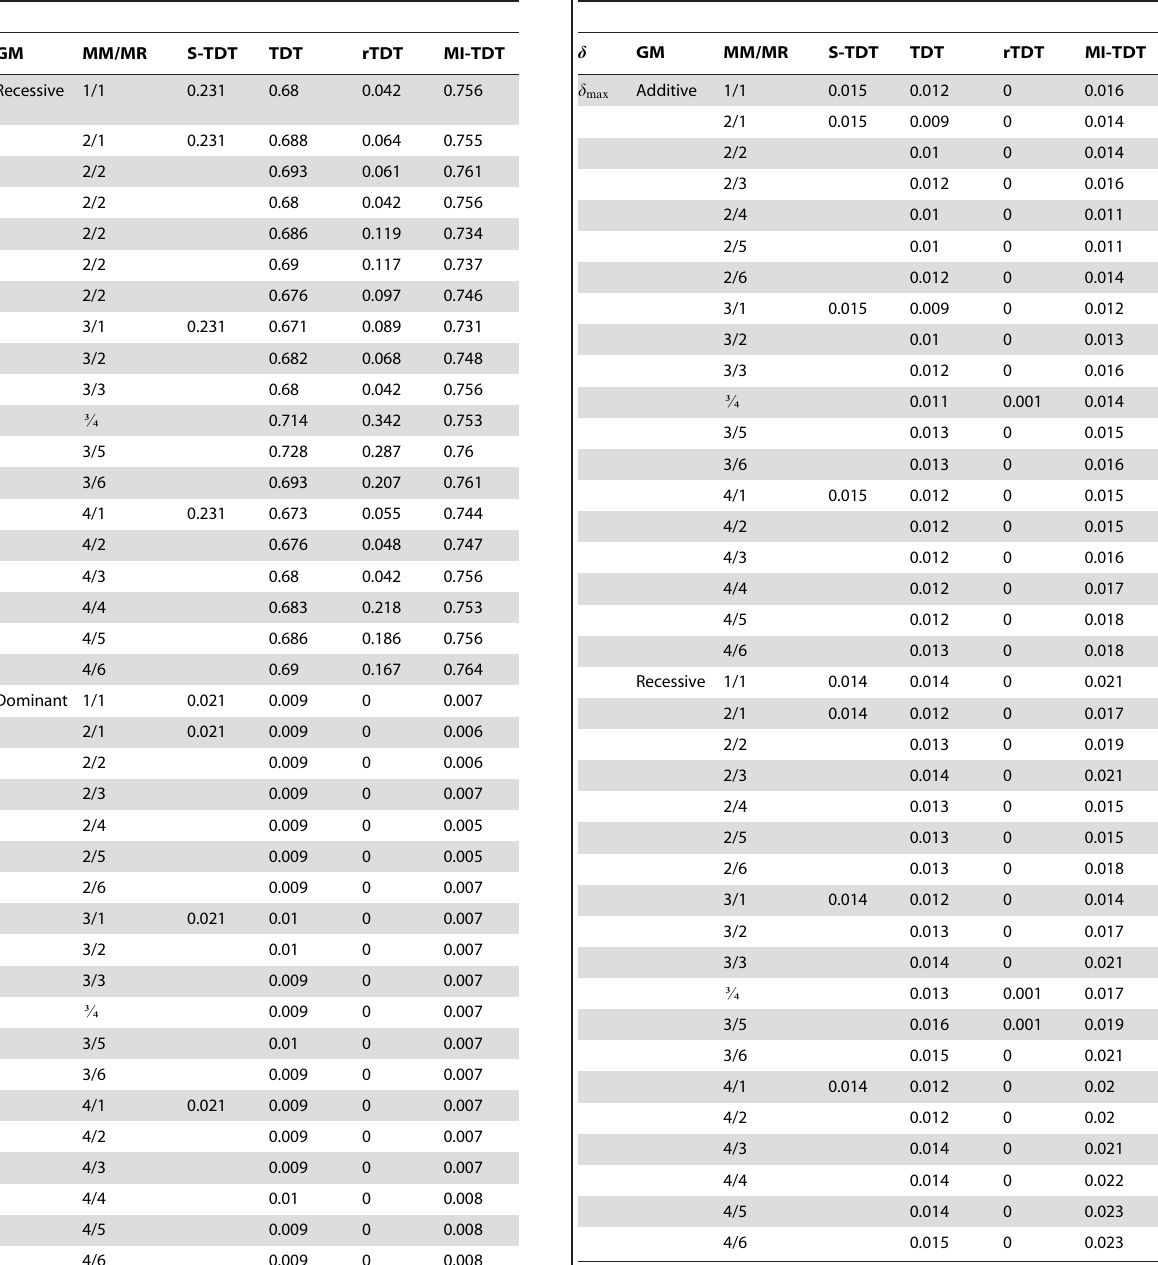
Table 11. Power analysis continues. Table 12. Power analysis